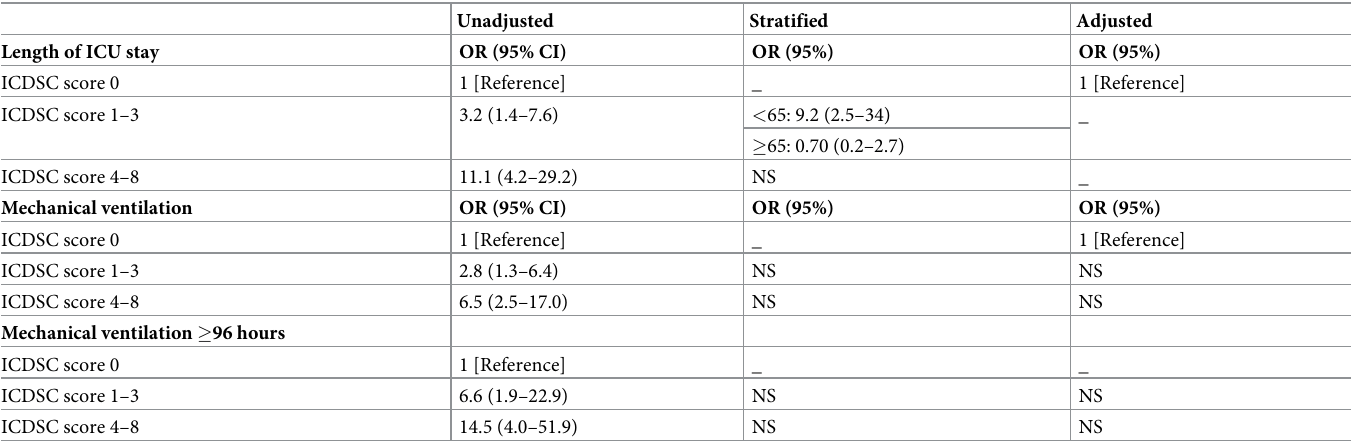
Table 5. Unadjusted, adjusted and stratified odds ratio estimates associations between prolonged length of ICU stay ( � 7 days) or mechanical ventilation (ever/ never) and ICDSC score. Unadjusted Stratified Adjusted Length of ICU stay OR (95%